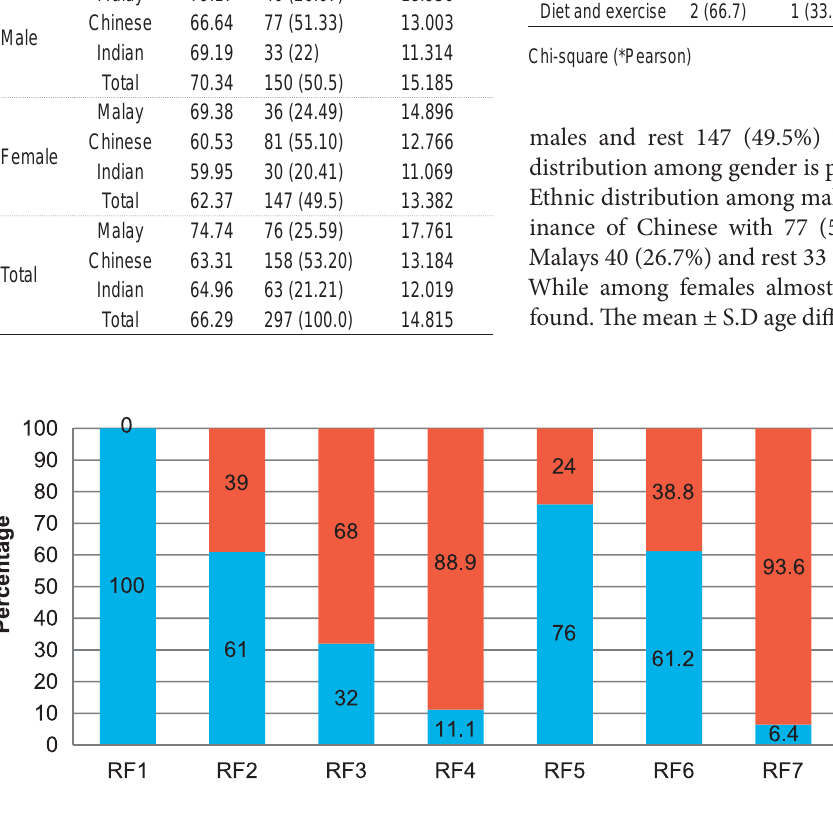
FIGURE 1. Clinical risk factors founds among enrolled patients. (RF1 = Diabetes, RF2 = Hypertension, RF3 = Hyperlipidemia, RF4 = Smoking, RF5 = Male >45years, RF6=Female>55years, RF7 = Hypoglycemia, RF8 = No exercise (3x/week>20min)).